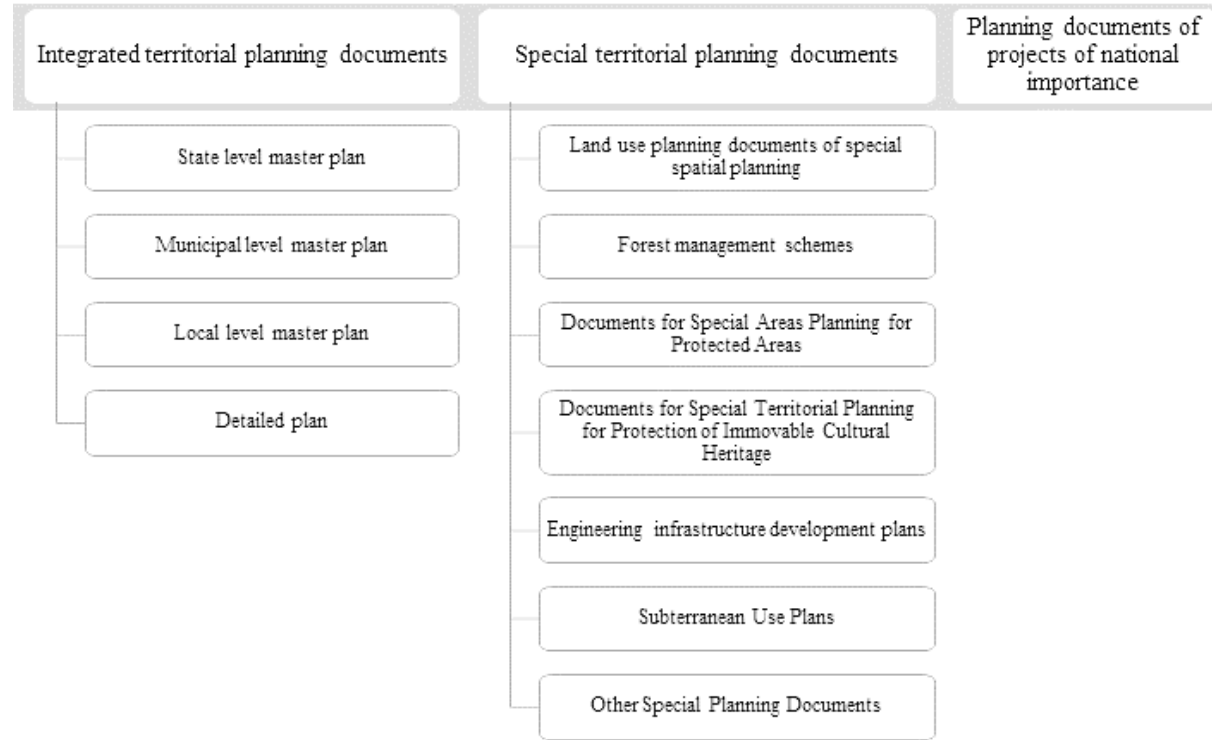
Figure 1. Classification of Territorial Planning